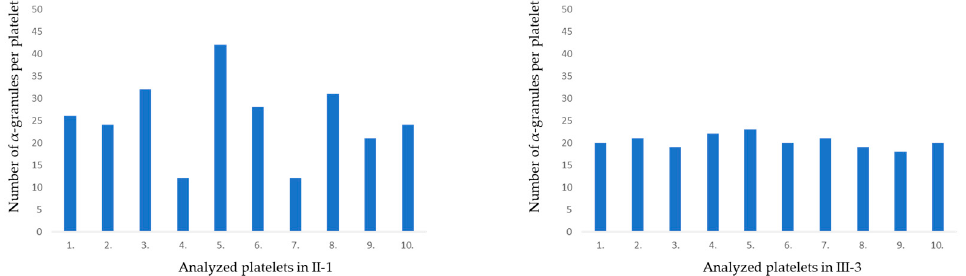
Figure 5. Histograms showing number of α -granules per platelet in patient II-1 and healthy indi- vidual III-3.